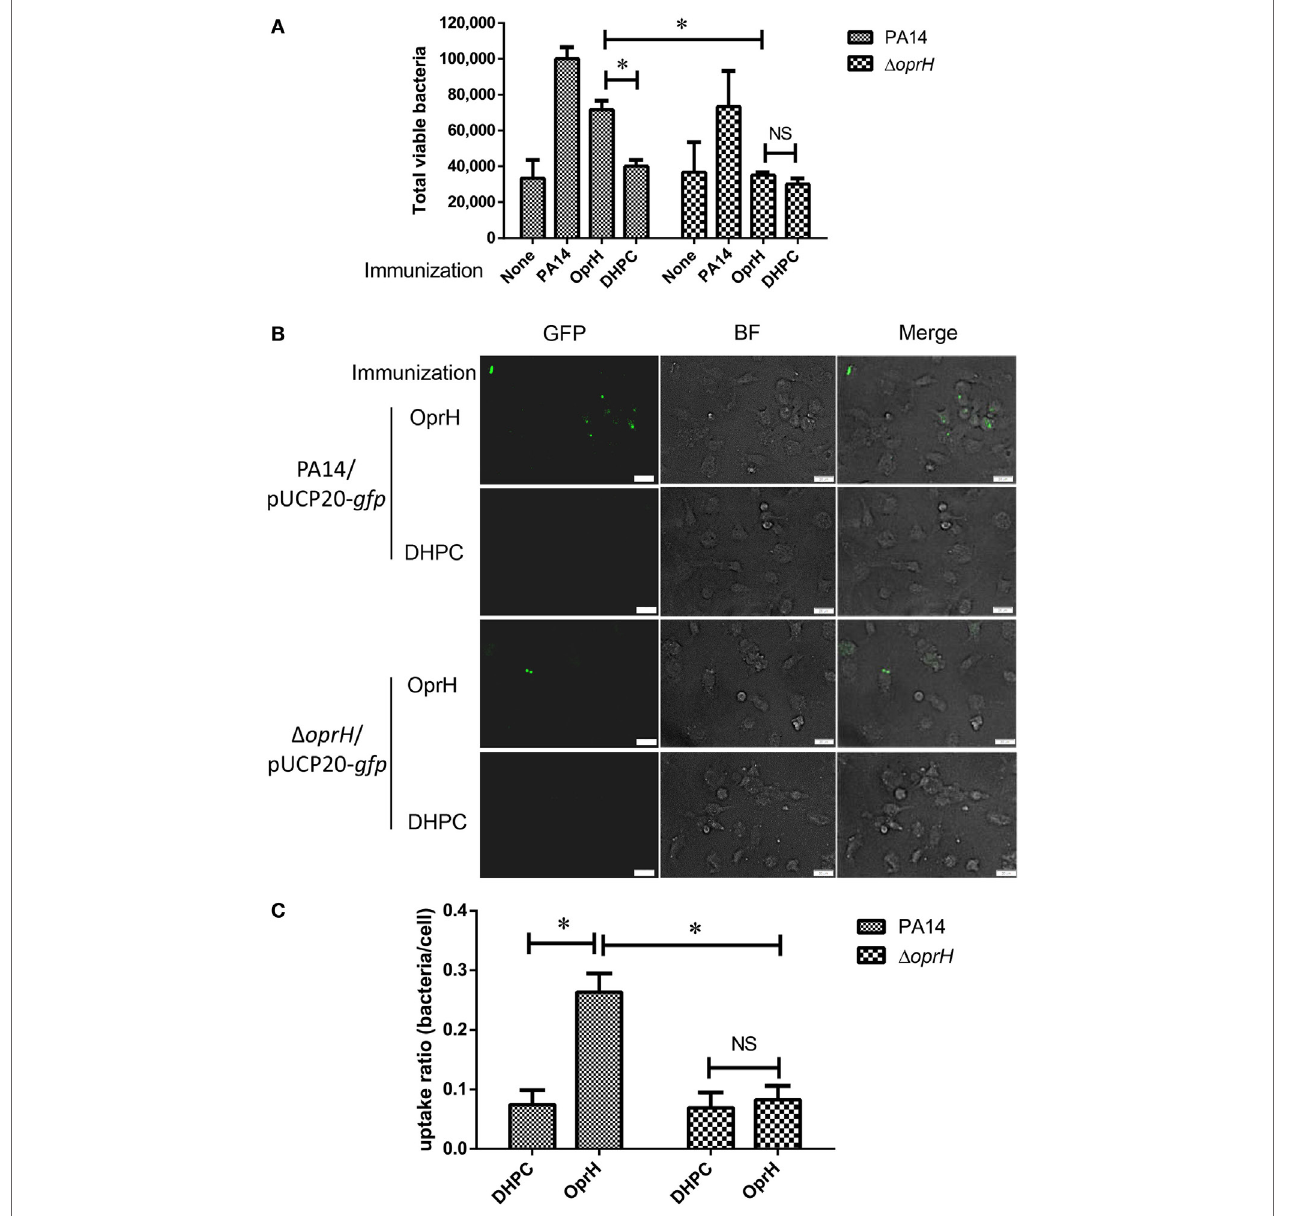
FigUre 6 | Opsonophagocytic uptake by BMDM in the presence of sera from immunized mice. (a) Opsonophagocytic uptake assays with wild-type PA14 and the Δ oprH mutant . Bacteria were premixed with sera from immunized mice and then incubated with BMDM. Values represent the mean total viable colonies captured by BMDM from three assay replicates for each sample. (B) Fluorescent bacteria (PA14/pUCP20- gfp and Δ oprH /pUCP20- gfp ) were subjected to the opsonophagocytic uptake assay. The uptaken bacteria were observed by fluorescent microscope. (c) The uptake ratio of bacteria by BMDM cells was calculated by counting cells in at least three fields of each sample. Abbreviations: BF, bright field; BMDM, bone marrow-derived